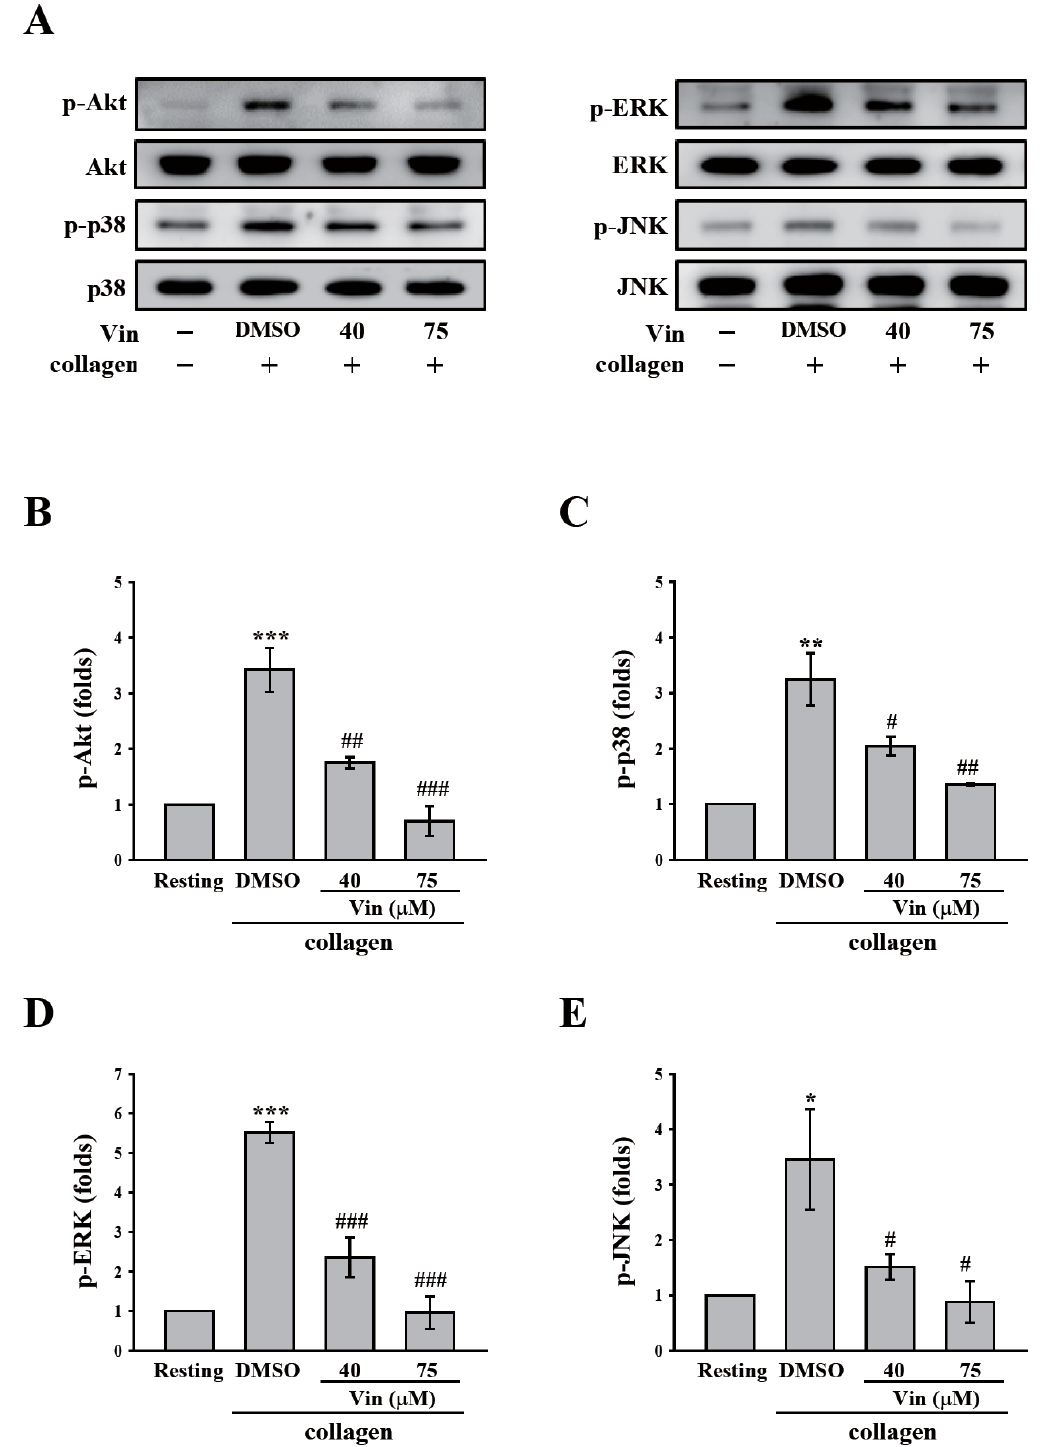
Figure 5. Effects of vincristine on collagen-mediated phosphorylation of Akt and MAPKs in human platelets. Washed platelets (3.6 × 10 8 cells/mL) were treated with vincristine (40 and 75 μ M) or DMSO before collagen treatment (1 μ g/mL). Protein extracts of platelets were subjected to Western blotting. The total and phosphorylated Akt, p38 MAPK, ERK, and JNK were detected using specific antibodies. Profiles in ( A ) are representative examples of three similar experiments. Data in ( B – E ) are presented as means ± standard error of the mean ( n = 3). * P < 0.05, ** P < 0.01, and *** P < 0.001 compared with the resting group. # P < 0.05, ## P < 0.01, and ### P < 0.001 compared with the DMSO (solvent control) group.